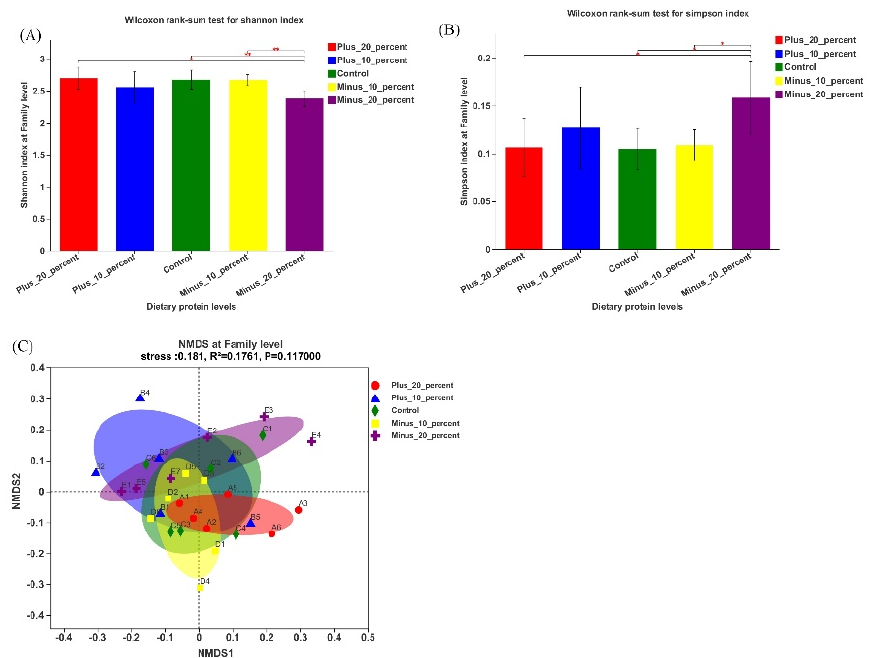
Figure 5. Shannon index plot, Simpson index plot, and NMDS plot for colonic microbiota of pigs fed different protein levels ( n = 6). ( A ) Shannon index plot of family level. ( B ) Simpson index plot of family level. ( C ) NMDS plot of family level. Plus_20_percent = +20%, Plus_10_percent = +10%, Minus_10_percent = − 10%, Minus_20_percent = − 20%. Significance levels were marked as * for P < 0.05 and ** for P < 0.01.